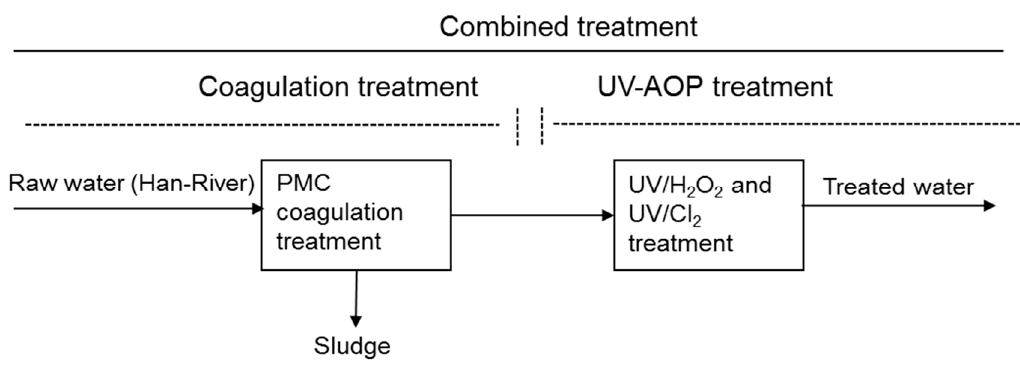
Figure 1. Schematic design of the combined treatment, plant-mineral composite (PMC) coagulation treatment followed by UV-based advanced oxidation processes (UV-AOP) treatment.